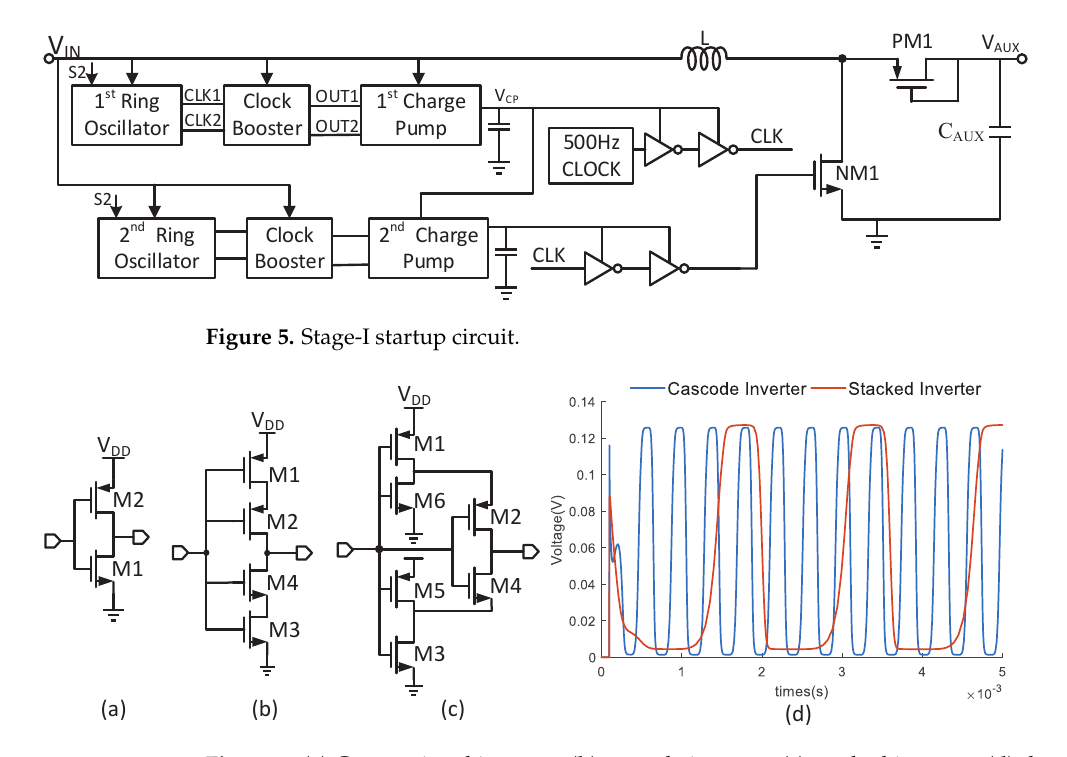
Figure 6. ( a ) Conventional inverter; ( b ) cascode inverter; ( c ) stacked inverter; ( d ) the oscillation of two ring oscillators.